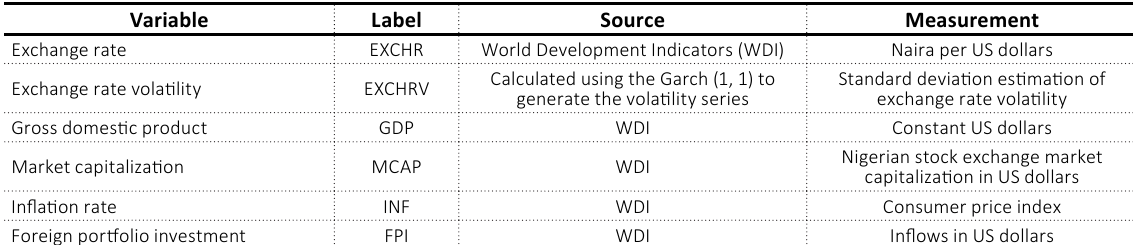
Table 1. Data sources and